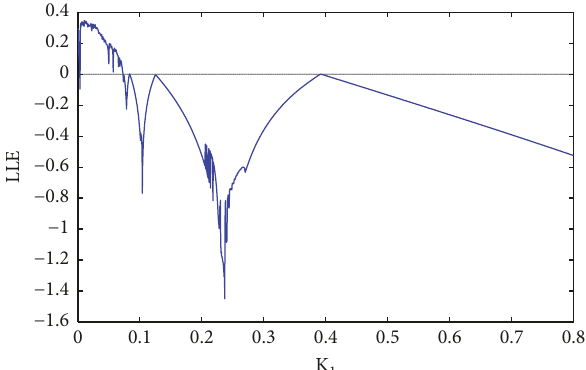
Figure 7: The largest Lyapunov exponent (LLE) plot of the supply chain system (10) with the controlling factor 𝐾 1 .